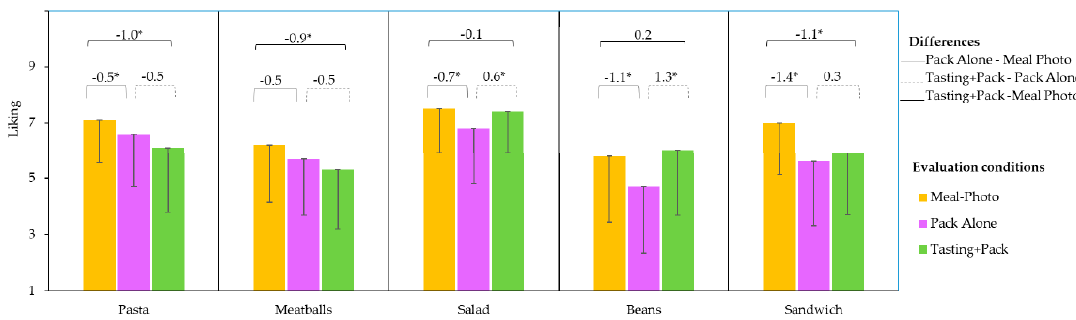
Figure 5. Liking mean values of each of the five meals evaluated on a plate (Meal-Photo condition), in the pack (Pack Alone condition), and after tasting with the packaging in view (Tasting+Pack condition). Differences between conditions (Pack- Meal Photo, Tasting Pack-Pack and Tasting pack- Meal Photo) are indicated with line segments over the top of the corresponding columns; significant differences are marked with an asterisk (*). Only the negative part of the standard deviation bars are shown for clarity.